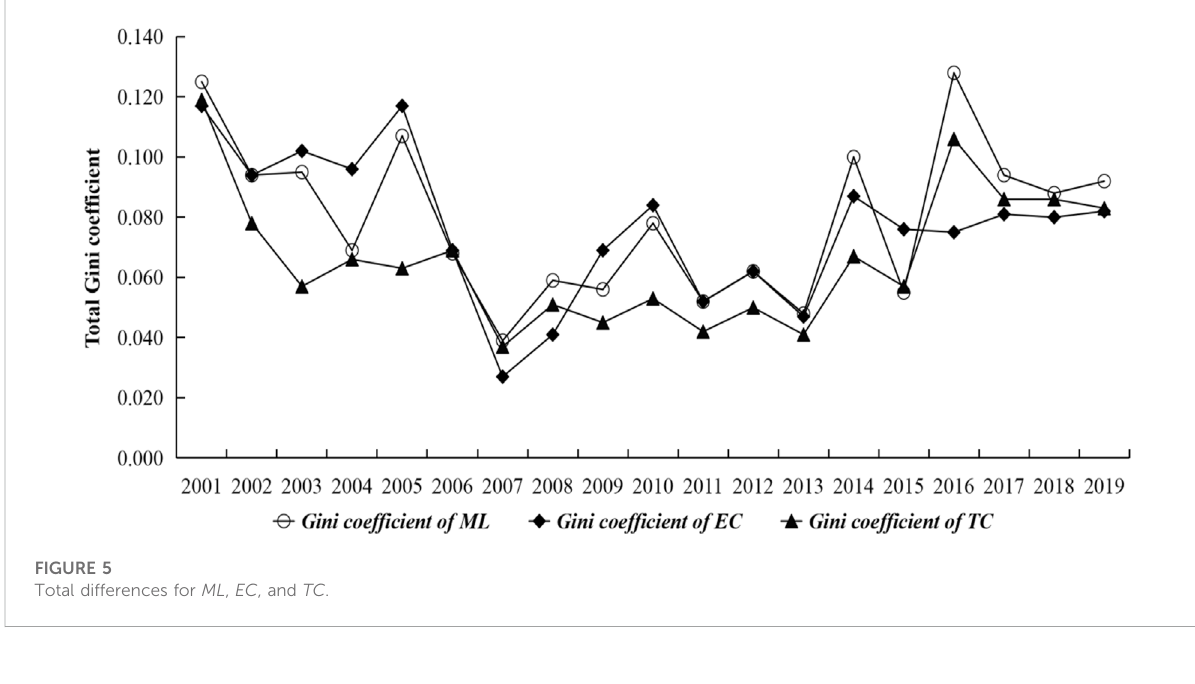
TABLE 3 DCEEIE ’ s difference within region of ML , EC , and TC